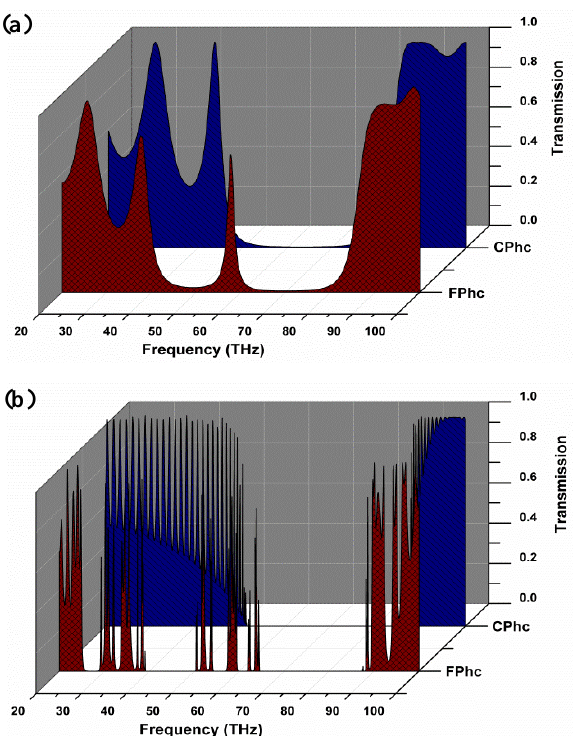
Figure 5: TE Transmittance spectrum of BiTeCl based Fibonacci Photonic crystal structures of (a) 5th and (b) 10th generations from 0° to 75°.